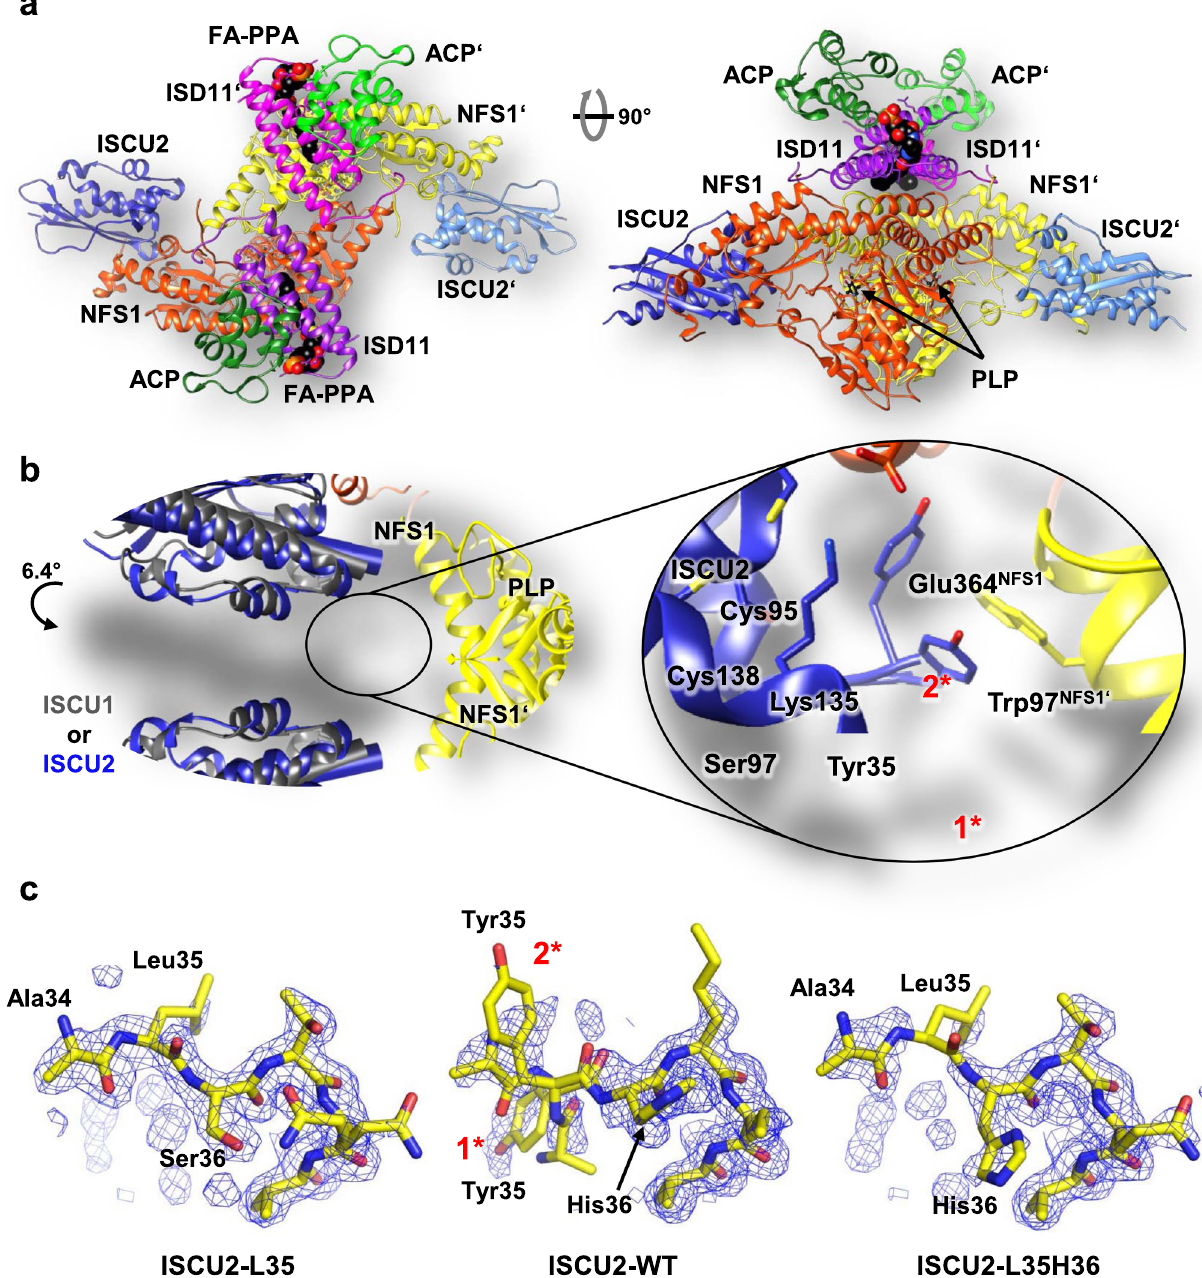
Fig. 2 High resolution crystal structures of (NIAU2) 2 complexes reveal fl exibility of the ISCU2 N terminus. a Overall architecture of the (NIAU2) 2 complex obtained by X-ray crystallography. NFS1 subunits are depicted in orange and yellow, ISD11 in purple and magenta, ACP in dark and light green, and ISCU2 in dark and light blue. Each NFS1 subunit covalently binds a pyridoxal phosphate (PLP), and ACP carries a fatty acyl phosphopantetheinyl (FA-PPA) moiety. b Detailed view of the 6° tilting of ISCU2 in (NIAU2) 2 relative to ISCU1 in (NIAU1) 2 28 . The conserved N-terminal Tyr35 of ISCU2 shows a dual localization within the crystal (inset). In one conformation (1*) Tyr35 stacks to Trp97 of NFS1 ’ , and in the other (2*) it contacts Glu364 of NFS1. c Effect of exchanges of Tyr35 and His36 of ISCU2 on the mobility of the N terminus (for detailed crystallographic statistics refer to Supplementary Table 2). Residues 34-39 of ISCU2 (mutants) are shown by sticks, and water molecules were omitted. The electron density ‘ omit ’ map 2Fo-DFc is displayed at 0.8 sigma level near the N terminus of ISCU2. The map was calculated after removing residues 34 – 38 from the model and re fi ning the model for one cycle with Phenix software. For stereo views refer to Supplementary Fig. 5c. Left: The mutant protein ISCU2-L35 shows a well-ordered N terminus with well-de fi ned electron density for all N-terminal residues (the density for the Leu sidechain is somewhat lower, suggesting increased mobility relative to the backbone); middle: wild-type ISCU2 shows poor electron density at the N terminus indicating high mobility, and was modeled with two possible conformations for Tyr35; right: The mutant protein ISCU2-L35H36 shows poorer electron density for the N terminus indicating that the His36 sidechain increases mobility.